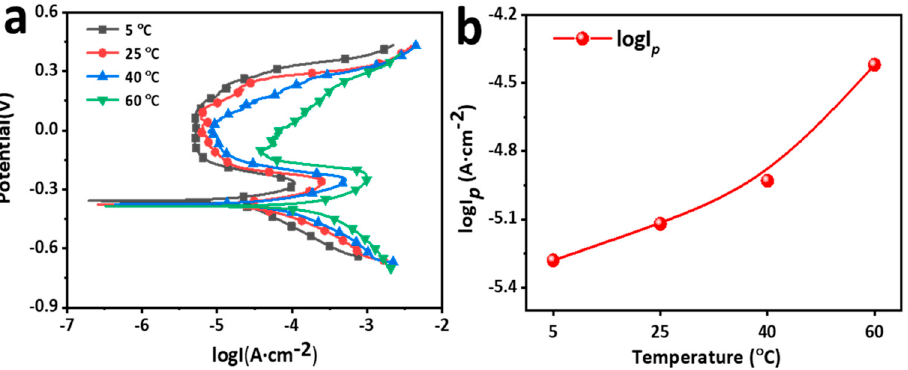
Figure 5. Potentiodynamic polarization curves of AlCoCrFeNi 2.1 in chloride-containing sulfuric acid solution at different temperatures: ( a ) PDP curve; ( b ) passivity current